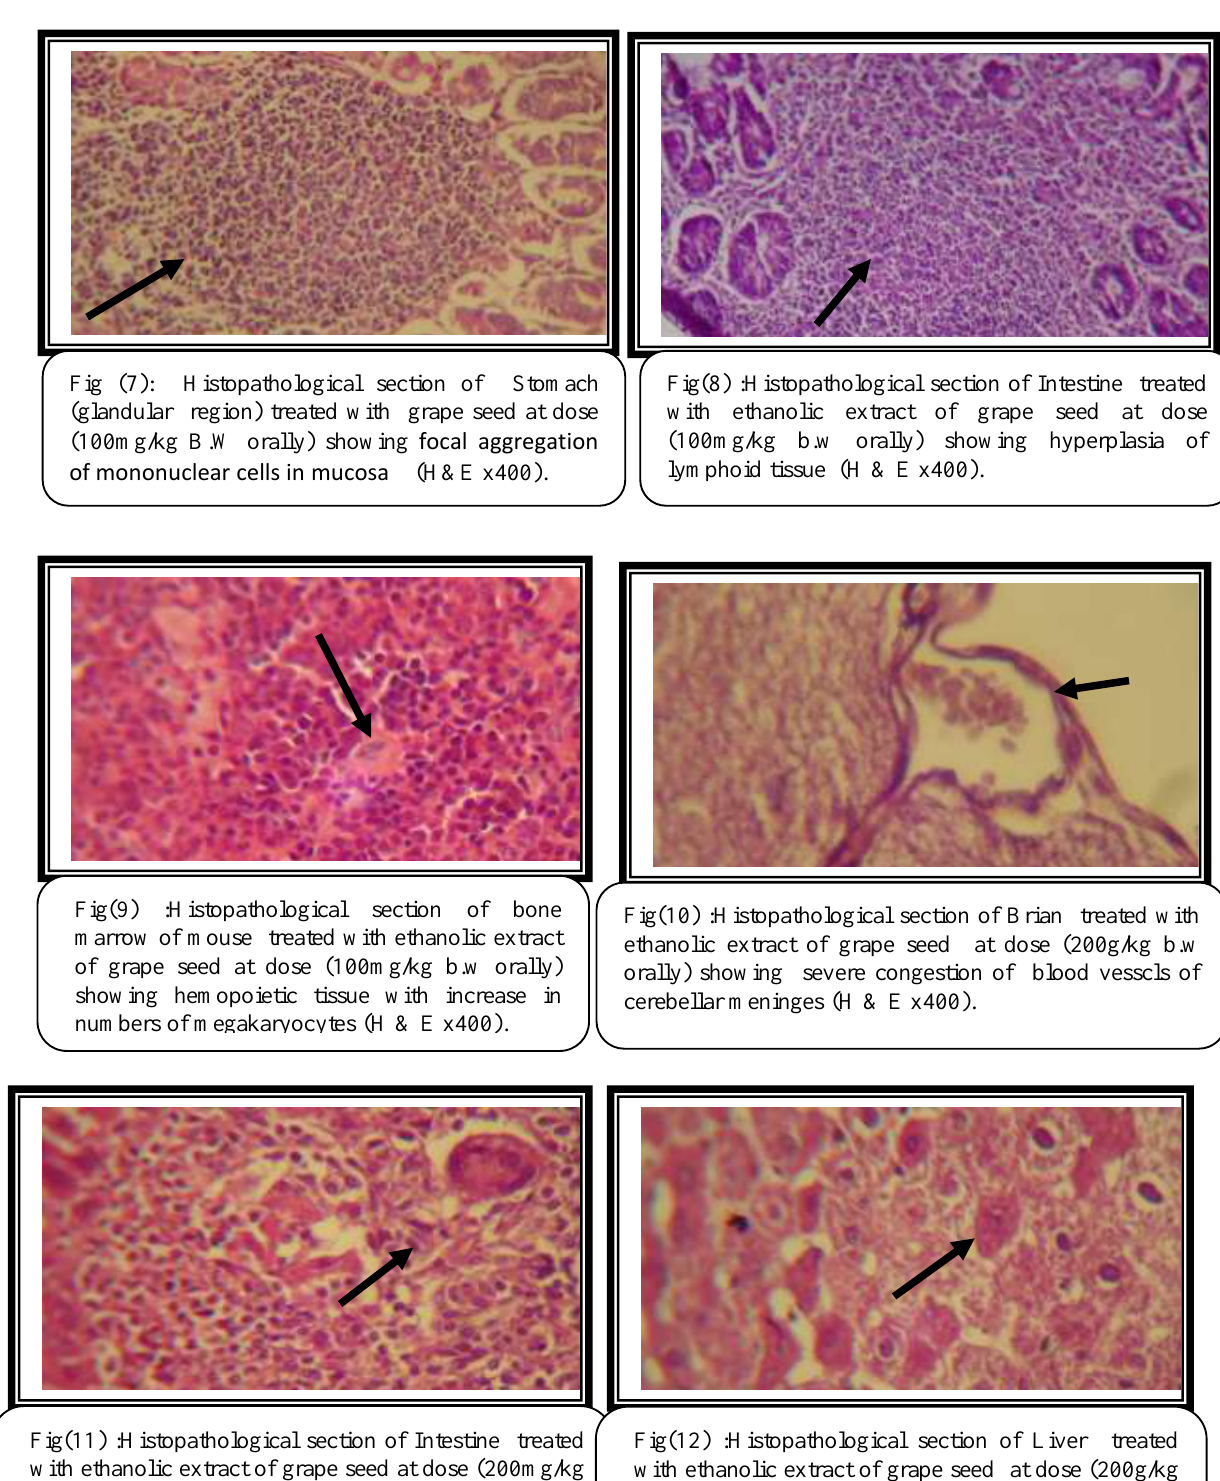
Fig(12) :Histopathological section of Liver treated with ethanolic extract of grape seed at dose (200g/kg b.w orally) showing extensive areas of necrosis and apoptosis (H & E